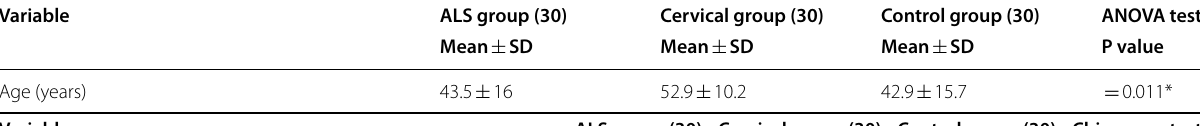
Table 5 Comparison between the three groups as regards socio‑demographic results using ANOVA and Chi‑square tests